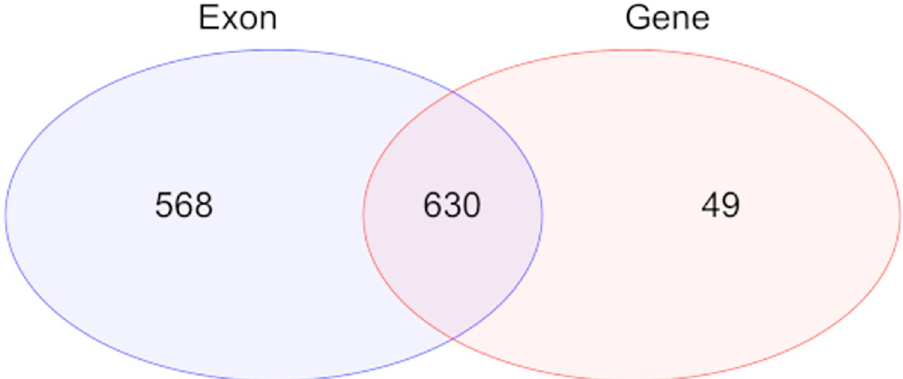
Fig 4. Venn Diagram of DEGs using exon and gene as feature type in categorizing reads by HTseq.